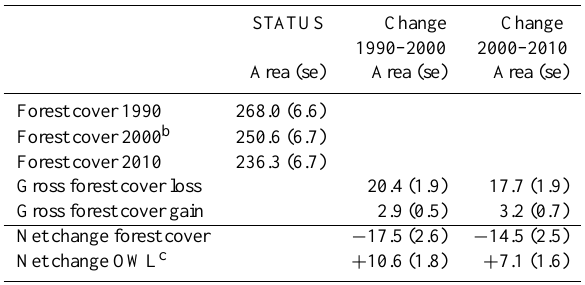
Table 2. Forest cover and change from 1990 to 2010 in Southeast Asia a (areas in